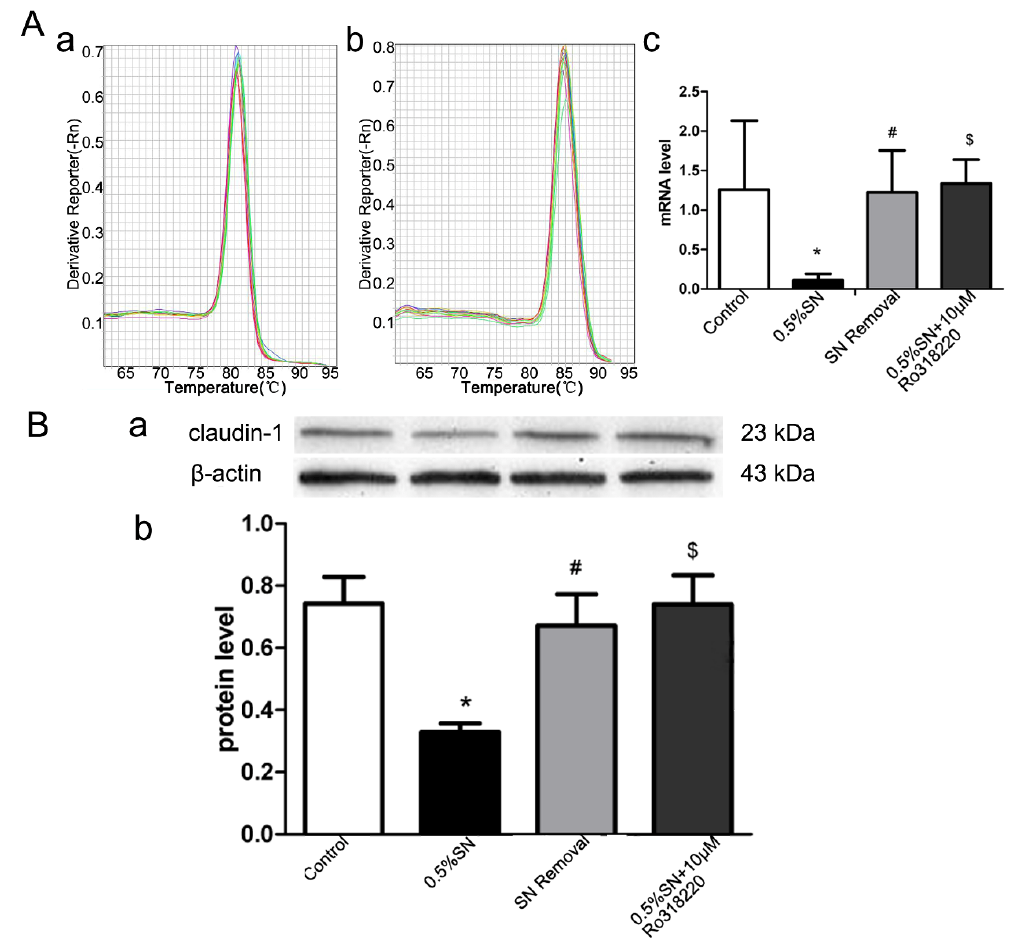
Figure 5. The mRNA and protein levels of claudin-1 expressed in different group. ( A ) The mRNA levels of claudin-1 expressed in different group. ( A-a ), ( A-b ) The melt curve of claudin-1 and β -actin in Real-time PCR, respectively; ( A-c ) Quantitative analysis from Real-time PCR data showed the fold values of the corresponding claudin-1 mRNA to that of β -actin mRNA in control, 0.5% SN treatment, SN removal and 0.5% SN + 10 μ M Ro318220 treatment group; ( B ) The protein levels of claudin-1 expressed in different group. ( B-a ) Western bolt data showed the claudin-1 protein expression levels of Caco-2 cell monolayers from control, 0.5% SN treatment, SN removal and 0.5% SN + 10 μ M Ro318220 treatment group, respectively; ( B-b ) Quantitative data showed the ratio of band density of the corresponding claudin-1 protein to that of β -actin protein in every group; ( C ) Immunofluorescent staining for localization of claudin-1 protein. Immunofluorescence microscopy for the localization of claudin-1 protein in Caco-2 cell monolayers using Alexa-Fluor ® 488-conjugated Affinipure Goat Anti-Rabbit IgG secondary antibody (green). Fuorescence images collected by inverted microscope. Scale bars: 5 μ m. ( C-a ), ( C-b ), ( C-c ), ( C-d ) Immunofluorescent staining of claudin-1 protein in Caco-2 cell monolayers from control ( C-a ), 0.5% SN treatment ( C-b ), SN removal ( C-c ) and 0.5% SN + 10 μ M Ro318220 treatment group ( C-d ), respectively. * p (SN treatment group vs . control group) < 0.05, # p (SN removal group vs . control group) > 0.05, $ p (SN + Ro318220 treatment group vs . control group) >